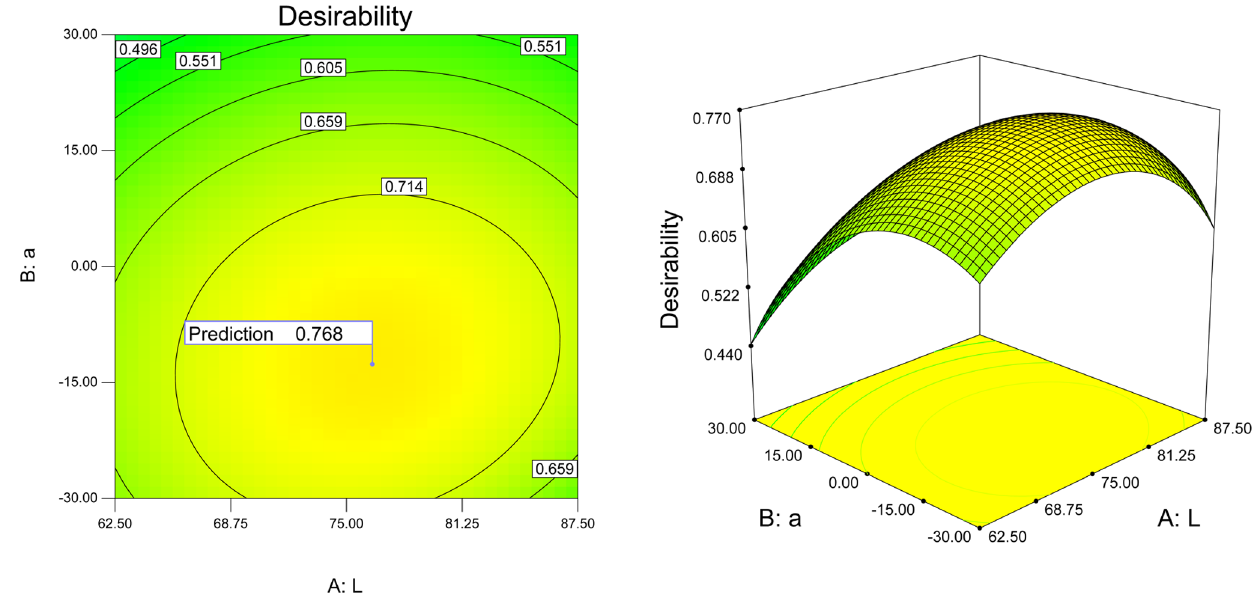
Figure 7. The contour and 3D plot of total desirability. doi:10.1371/journal.pone.0090646.g007 PLOS ONE |